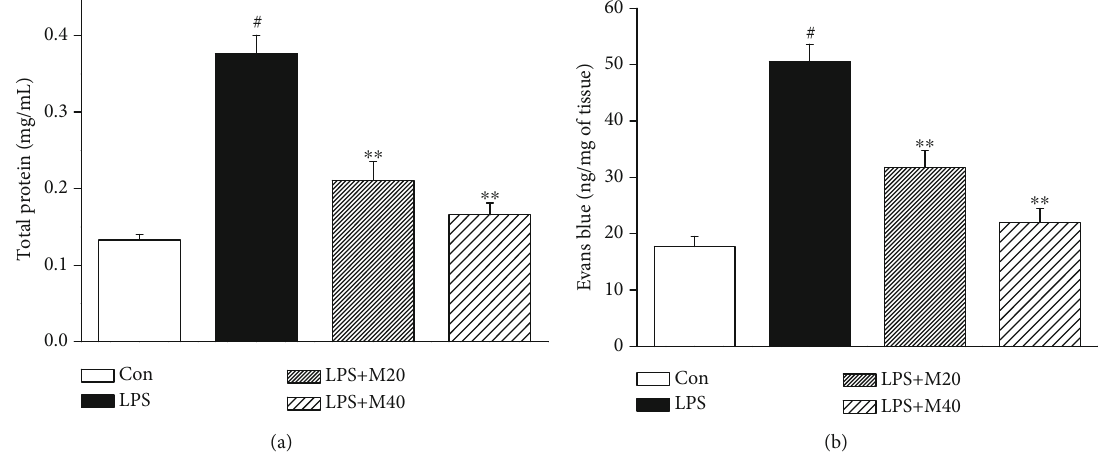
Figure 2: Mibefradil decreased total protein concentration in BALF and inhibited Evans blue extravasation in lung tissue. Mibefradil (20 and 40mg/kg) was administrated 30min before LPS exposure. Mice were sacri fi ced 6h after LPS challenge and bronchoalveolar lavage was processed. (a) The concentration of total protein in BALF was measured. (b) Evans blue dye (30 mL/kg, i / v ) was injected 0.5h before sacri fi ce. Evans blue accumulation in the lung tissue was examined to test pulmonary vascular permeability. All values are mean ± SEM ( n = 6 ). # p < 0 : 05 , signi fi cant compared with vehicle-treated control; ∗ p < 0 : 05 , signi fi cant compared with LPS alone; ∗∗ p < 0 : 01 , signi fi cant compared with LPS